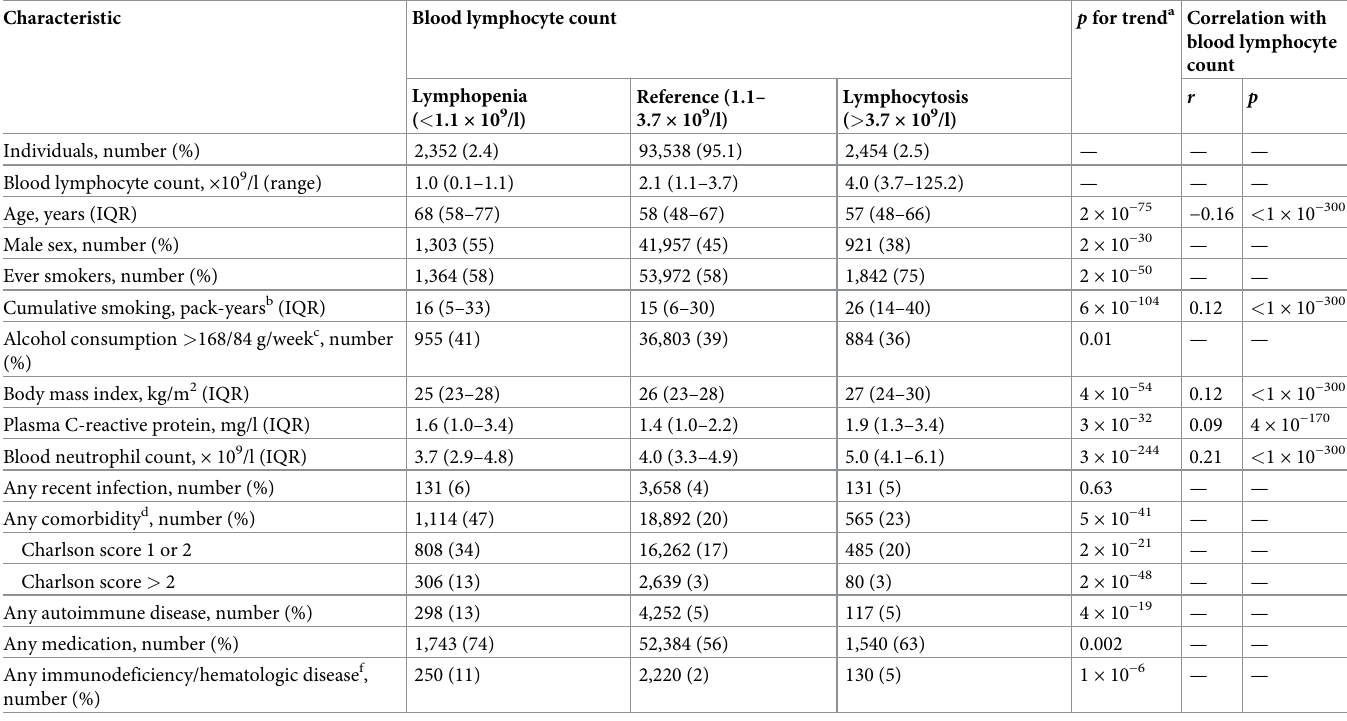
Table 1. Baseline characteristics of 98,344 individuals from the Copenhagen General Population Study according to blood lymphocyte count. Characteristic